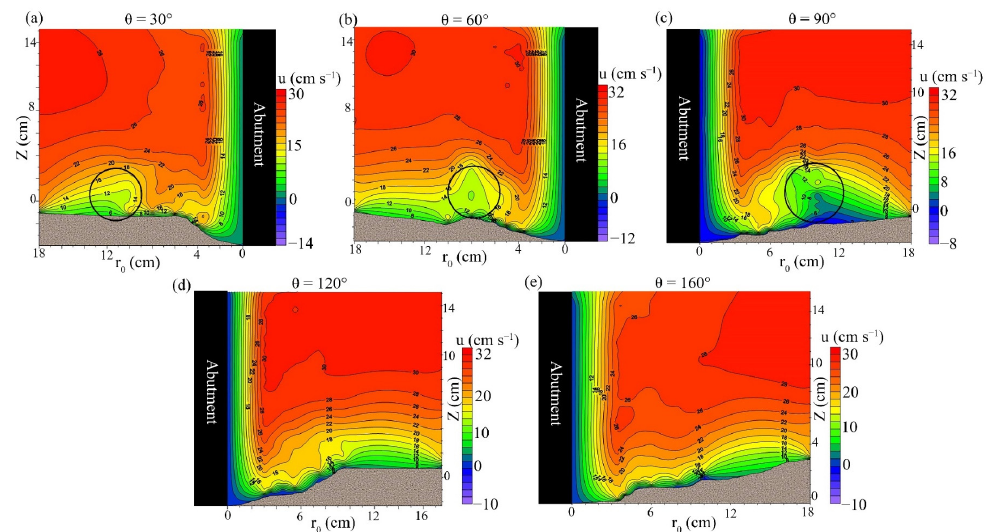
Figure 7. Velocity field for the case with a vegetated bed in the tangential direction (u, cm/s) at different azimuthal sections. Note that the range of the color scale is not equalized for better illustration.